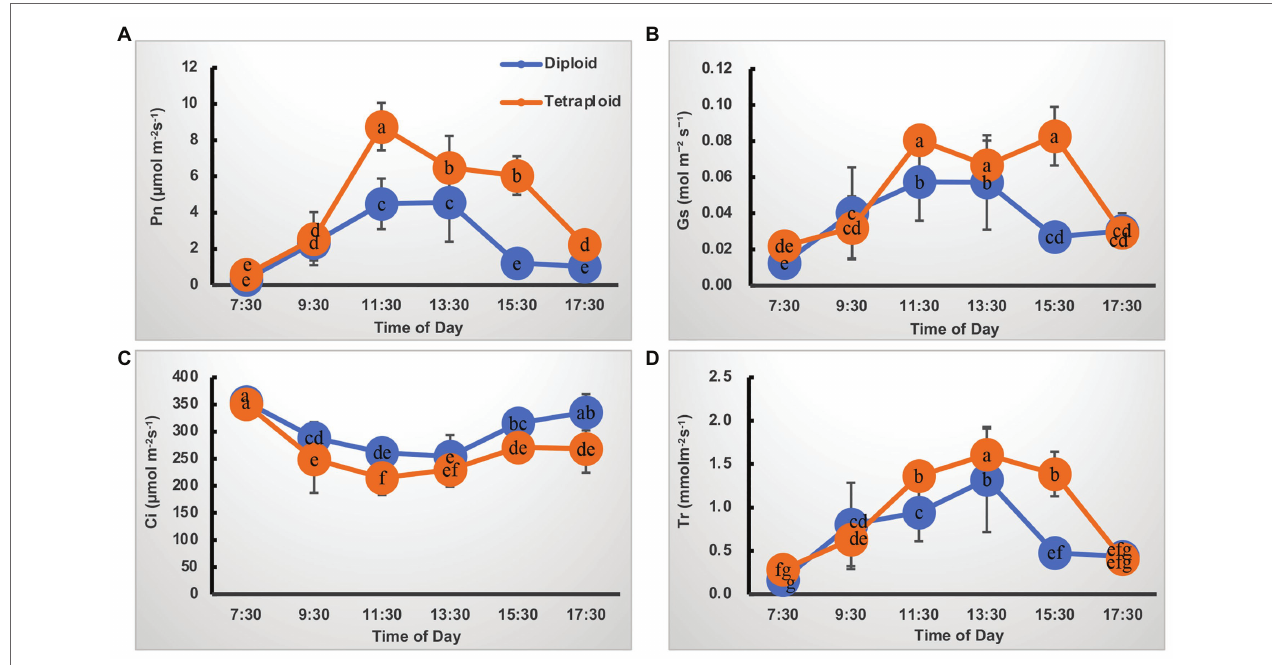
FIGURE 2 | Diurnal variation of photosynthetic characteristics of the diploid and tetraploid barley plants. (A) Net photosynthetic rate (Pn). (B) Stomatal conductance (Gs). (C) Intercellular CO 2 concentration (Ci). (D) Transpiration rate (Tr). Different letters represent significant differences (of Pn or Tr or Gs or Ci) between diploid and tetraploid barley at different time points ( n =